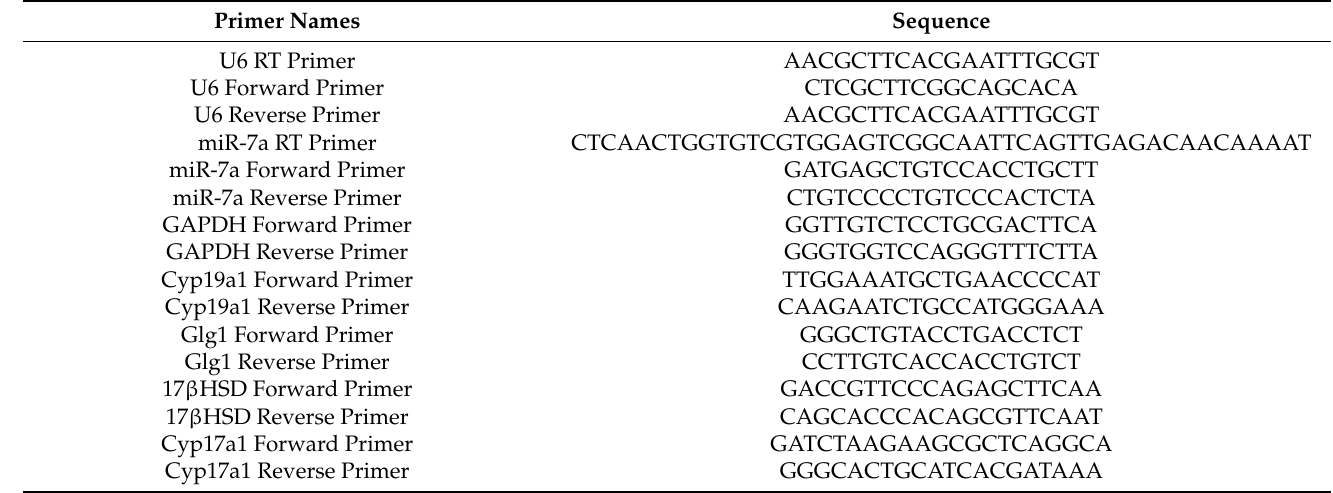
Table 1. PCR primer